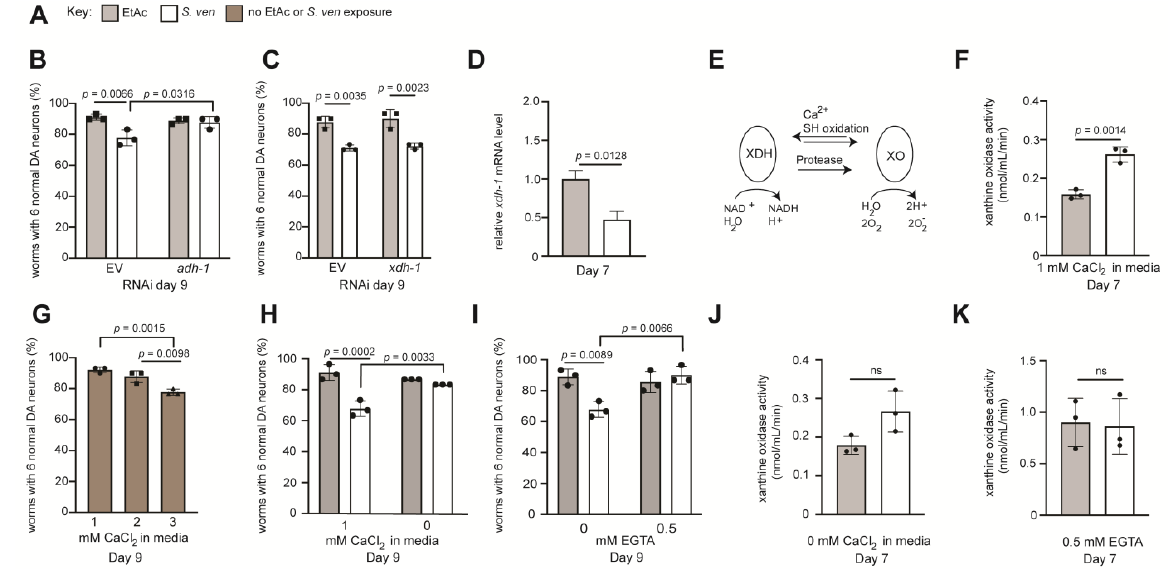
Figure 6. S. ven metabolite induces xanthine oxidase activity dependent on the presence of calcium. ( A ) Key in which the gray bars represent EtAc treatment, white bars are S. ven treatment, and light brown bars have no treatment. ( B ) C. elegans DA neurodegeneration on adult day 9 animals following RNAi of adh - 1 in the presence of EtAc or S. ven metabolite treatment. Loss of adh - 1 resulted in decreased neurodegeneration in animals exposed to S. ven metabolite alone and compared to the S. ven metabolite EV control. ( C ) C. elegans DA neurodegeneration in adult day 9 animals (P dat-1 ::GFP) following RNAi of xdh - 1 in the presence of EtAc or S. ven metabolite treatment. Loss of xdh-1 had no impact on DA neurodegeneration in animals exposed to S. ven metabolite ( D ) Quantification of xdh - 1 mRNA gene expression levels in adult day 7 animals following exposure to EtAc or S. ven metabolite. ( E ) Model depicting interconversion of XDH to XO. The accumulation of XO can occur through an interaction with calcium; it increases ROS. ( F , J , K ) Ex vivo xanthine oxidase activity assays. ( F ) Xanthine oxidase activity was measured in day 7 adult worms following chronic exposure to EtAc or S. ven metabolite treatment when the normal amount of calcium (1 mM) was added to the worm media. ( G ) C. elegans DA neurodegeneration in adult day 9 animals (P dat-1 ::GFP) following exposure to increasing amounts of CaCl 2 (1, 2 or 3 mM) within the NGM media. 3 mM CaCl 2 resulted in enhanced neurodegeneration. ( H ) Adult day 9 animals grown on plates without CaCl 2 (0 mM CaCl 2 ) within the NGM media displayed reduced DA neurodegeneration following chronic exposure to S. ven metabolite compared to the 1 mM S. ven control. ( I ) C. elegans were exposed to 0 or 0.5 mM EGTA, along with S. ven . Neuroprotection from S. ven was observed when worms were also exposed to the calcium chelator, EGTA. ( J ) Xanthine oxidase activity was measured in day 7 adults chronically exposed to EtAc or S. ven metabolite when worms were grown on plates when CaCl 2 was omitted from the NGM media. ( K ) Xanthine oxidase activity was measured in day 7 adults chronically exposure to EtAc or S. ven metabolite when worms were grown on plates supplemented with 0.5 mM EGTA in addition to EtAc or S. ven metabolite. For all neurodegeneration experiments, data are represented as mean +/ − SD; n = 30 animals per replicate, three independent replicates per treatment; one-way ANOVA or two-way ANOVA with Tukey’s post hoc test for multiple comparisons. Xanthine oxidase activity was analyzed with Student’s t -test and presented as mean +/ − SD; at least 120 animals were used for each replicate, 3 biological replicates. The RT-qPCR data were normalized to EtAc control. Significance is represented by using exact p -values. qPCR mRNA data analyzed by Student’s t -test and presented as mean +/ − SEM of three biological replicates, with three technical replicates each; at least 100 animals were used for each replicate. ns = not